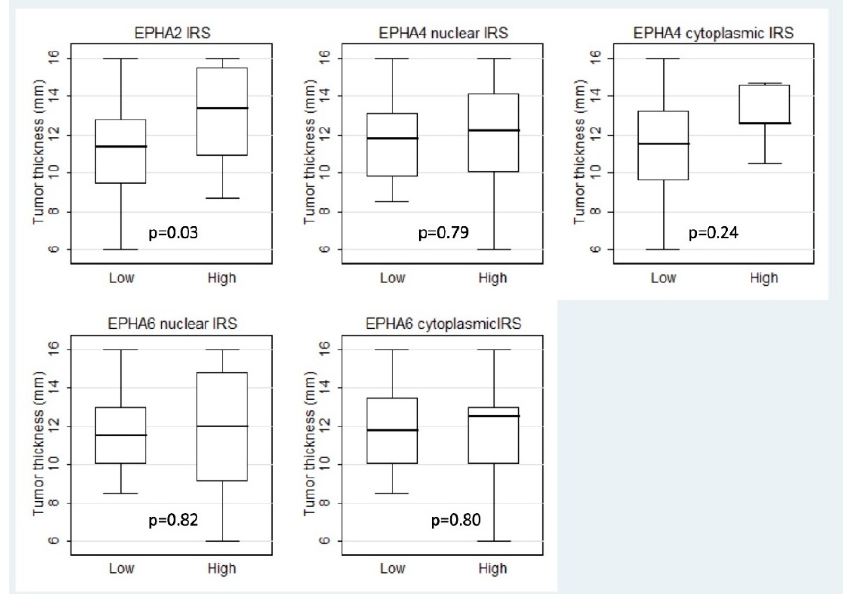
Figure 2. Associations of tumor thickness with EPHA2, EPHA4, and EPHA6 IRS. The low IRS group includes the cases that exhibited completely negative staining.